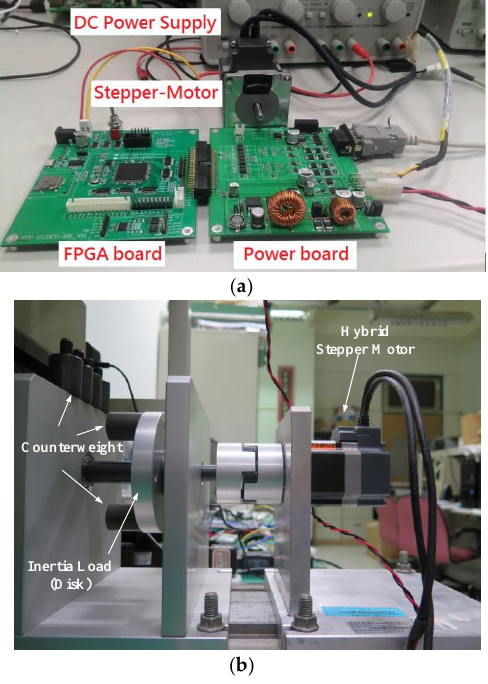
Figure 1. The setup for experiment. ( a ) The field programmable gate array (FPGA) board and power module; ( b ) the experimental platform.